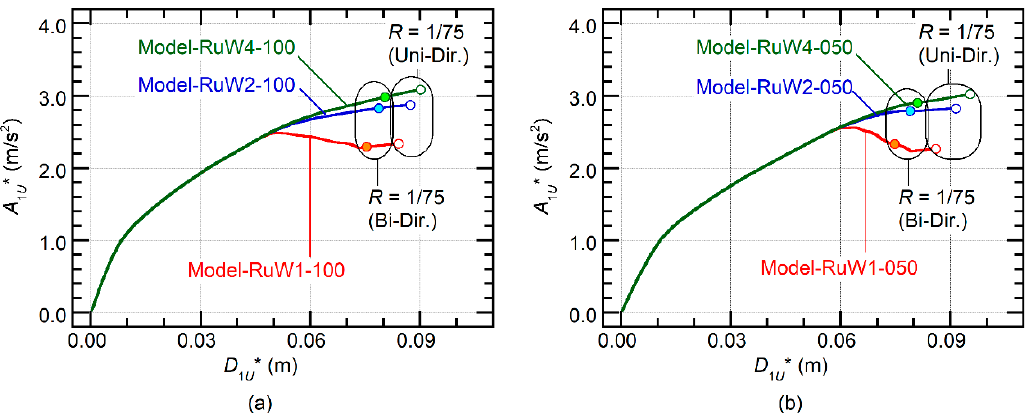
Figure 25. Comparison of the capacity curve of each model: ( a ) Models RuW1-100, RuW2-100, and RuW4-100, ( b ) Models RuW1-050, RuW2-050, and RuW4-050.